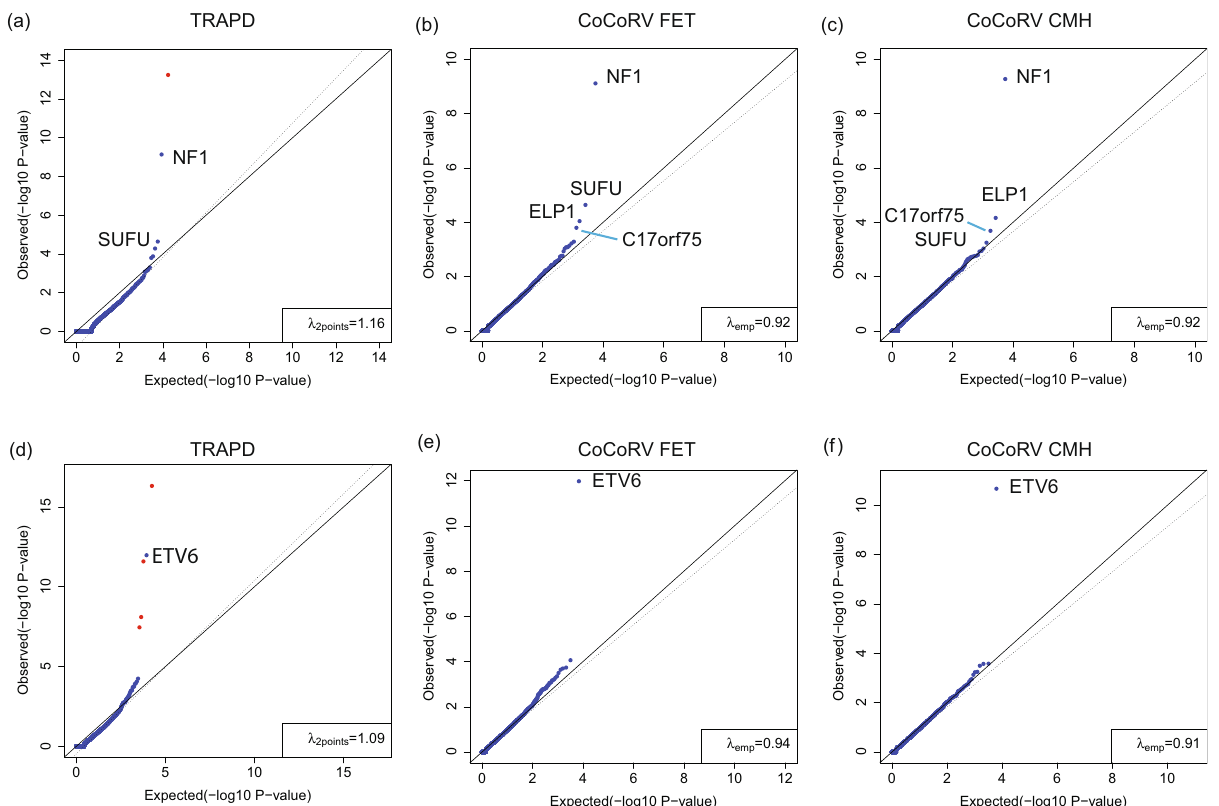
Fig. 6 CoCoRV and TRAPD analyses of the CNS and ALL cohorts. We used gnomAD summary counts as controls. a – c The analyses of the CNS cohort using TRAPD ( a ), CoCoRV with the two-sided Fisher ’ s exact test (FET) ( b ), and CoCoRV with the two-sided Cochran – Mantel – Haenszel (CMH) exact test ( c ). d – f The analysis of the ALL cohort using TRAPD with the two-sided FET ( d ), CoCoRV with the two-sided FET ( e ), and CoCoRV with the two-sided CMH-exact test ( f ). Red dots in ( a ) and ( d ) indicate false-positive genes that pass the exome-wide signi fi cance threshold ( P < 2.5e-6). All P values are raw P values without multiple testing